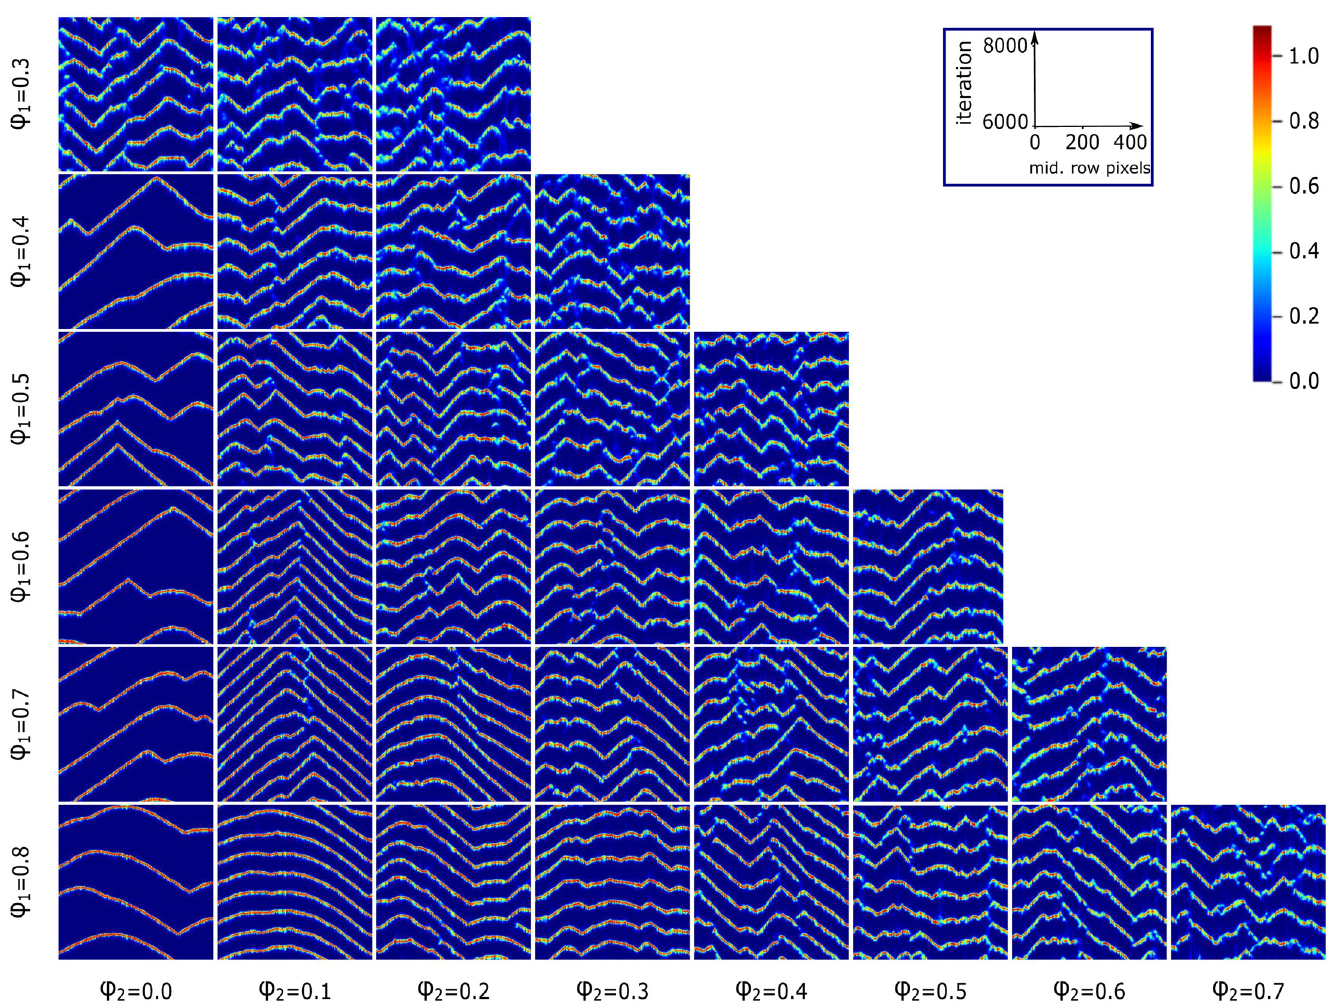
Fig 5. The square root of u concentration along amid row pixels of the networks during the last 2000 iterations of simulations in lattices of 400 × 400 size, covered with mixed populations with different pairs of ϕ 1 and ϕ 2 . ϕ 1 is the population density of the whole cells on each lattice and ϕ 2 is the fraction of reactive/less- cooperative cells among the population. The related row and column of each pattern in the array are appointed by their ϕ 1 and ϕ 2 indicated in vertical and horizontal margins, respectively.